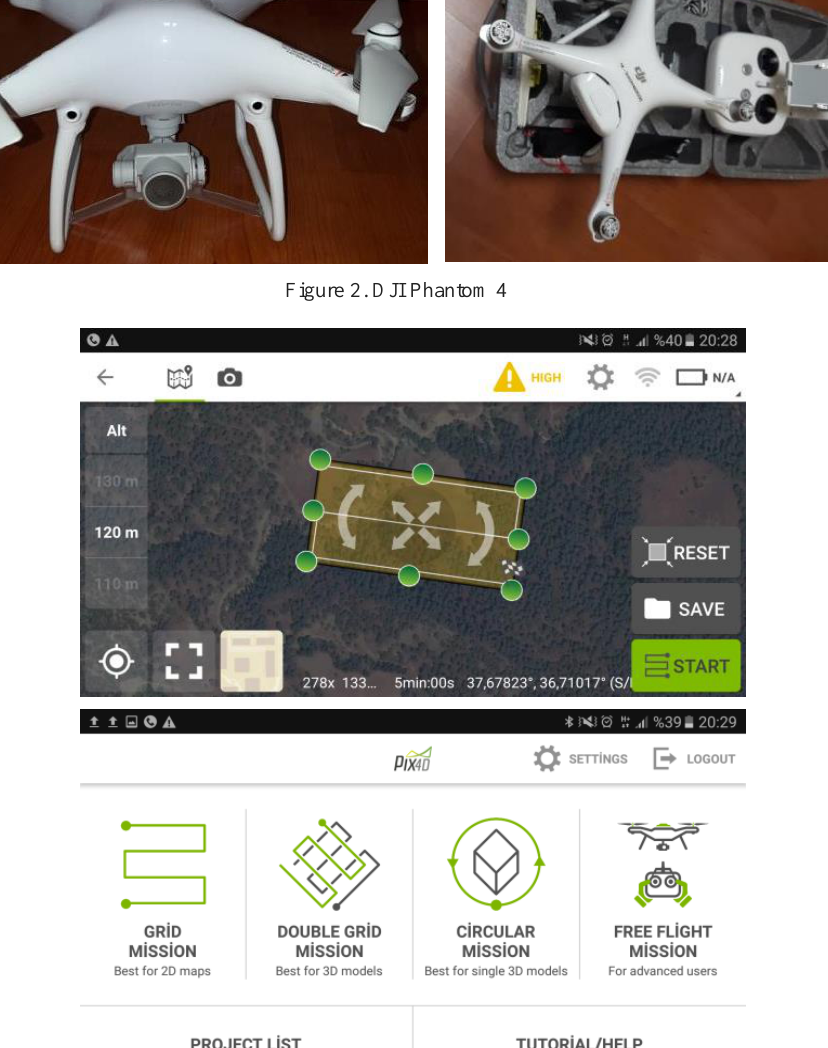
Figure 3. Interface overview of Pix4D Capture in the field (above) and planned flight path